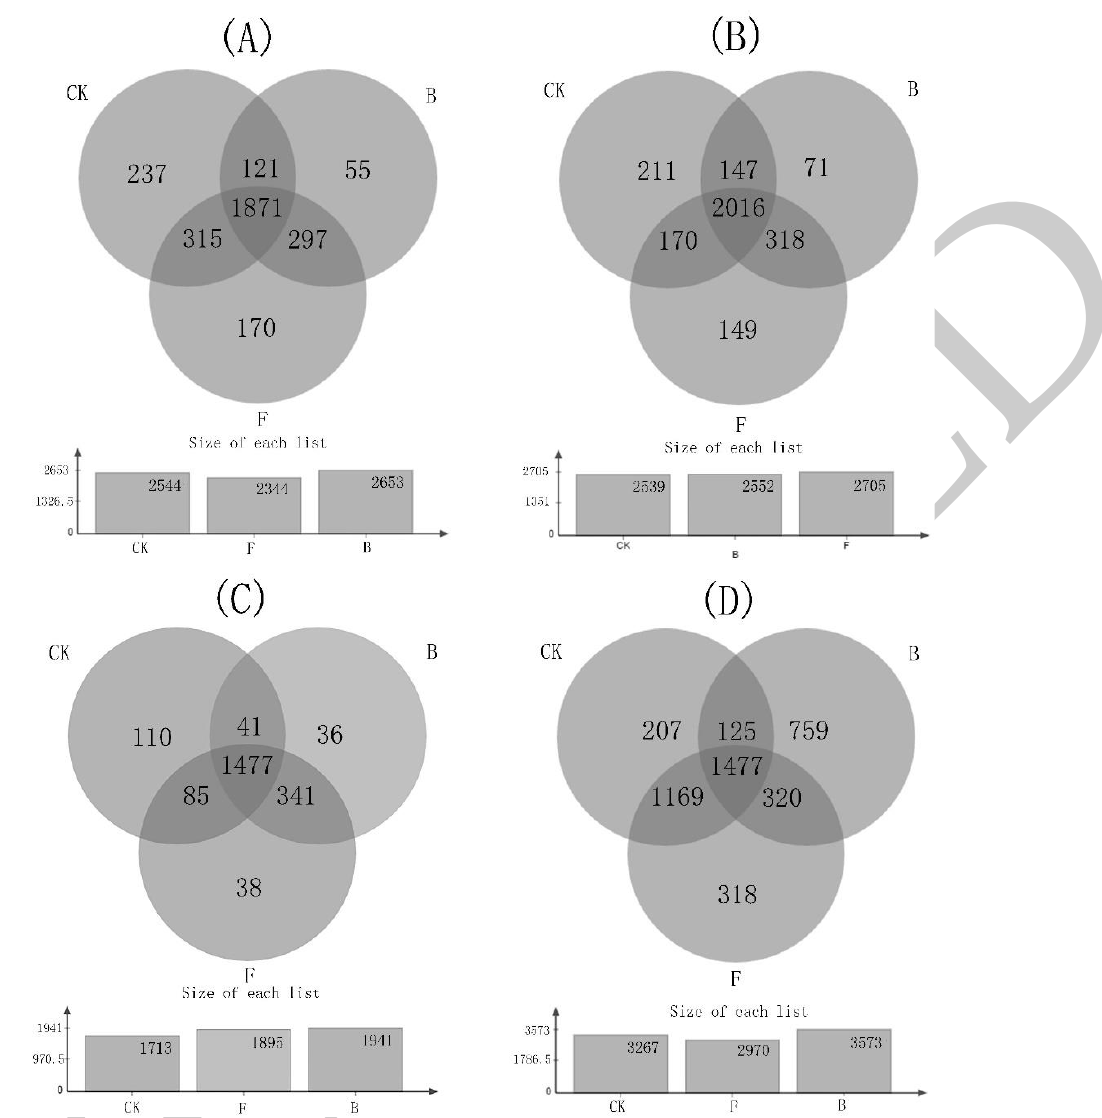
Figure 1. Analysis of β diversity of soil bacteria at the OTU level. ( A – D ) represent Shaowu City, Fujian Province (FUS); Chenzhou City, Hunan Province (HUS); Xuchang City, Henan Province (HES); and Mudanjiang City, Heilongjiang Province (HEIS), respectively.